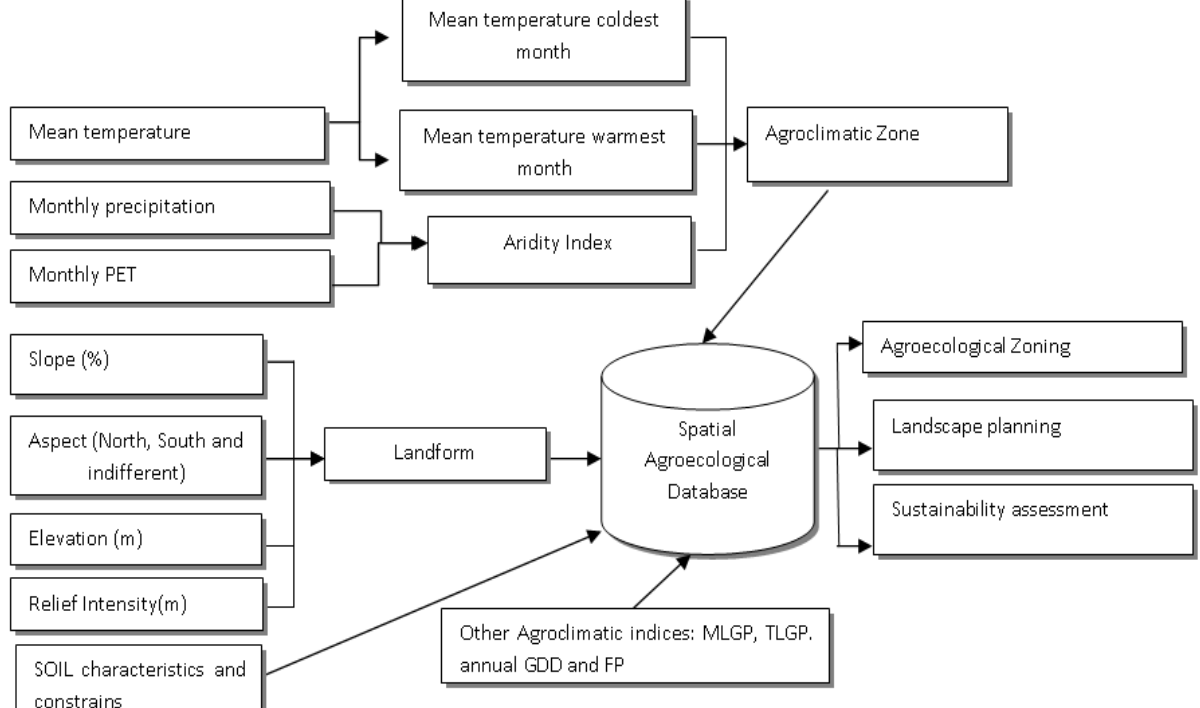
Fig. 2. Framework and information flow for create spatial database and agroecological